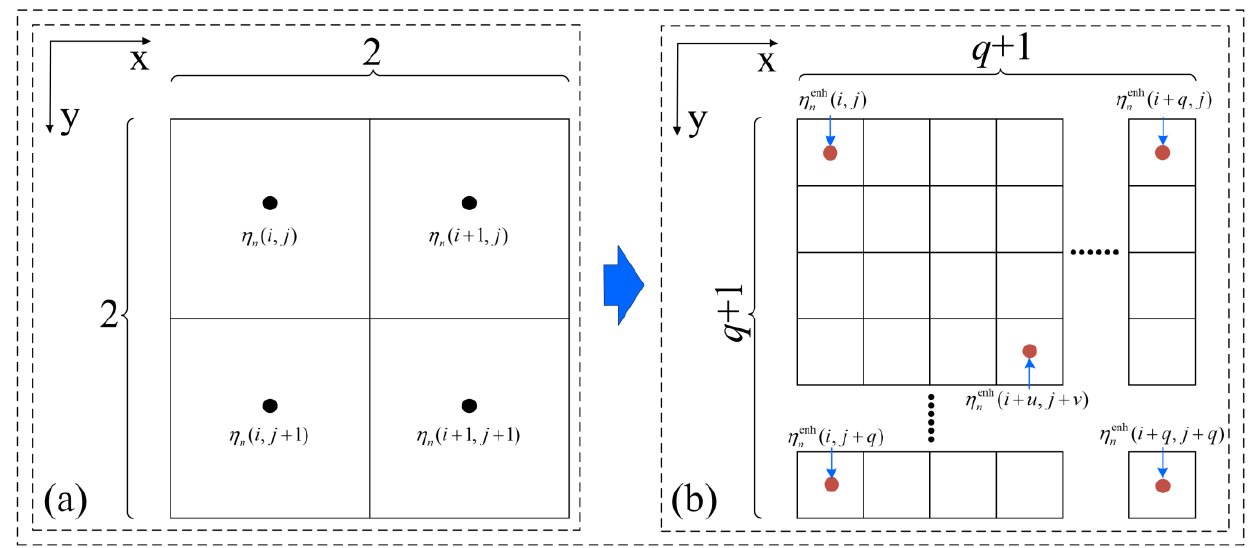
Figure 1. Schematic diagram of the bilinear interpolation algorithm: ( a ) before interpolation; ( b ) after interpolation.